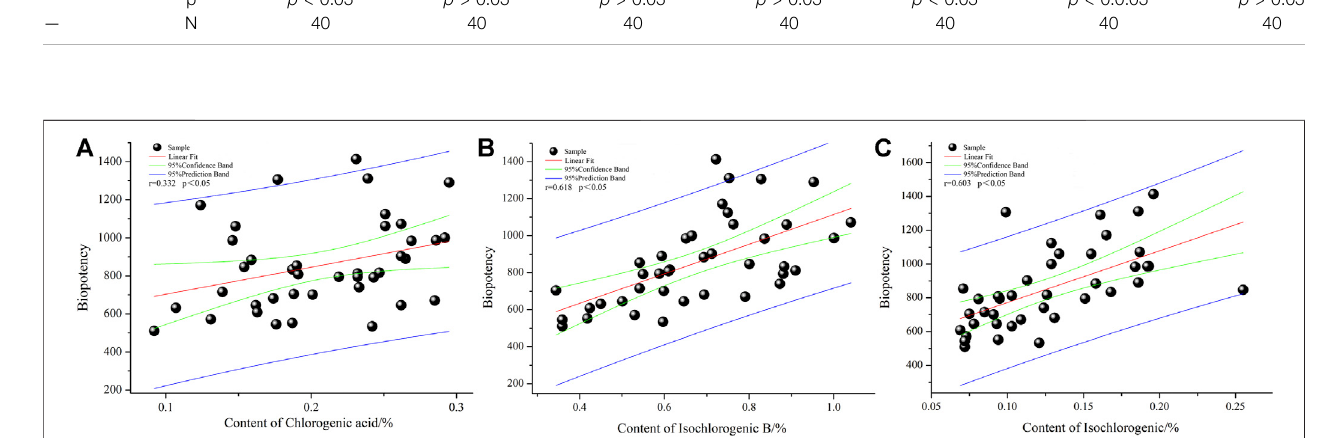
FIGURE 5 | The COX-2 inhibition biopotency and chemical composition content correlation analysis. (A) : chlorogenic acid; (B) : isochlorogenic acid B and (C) : isochlorogenic acid C.